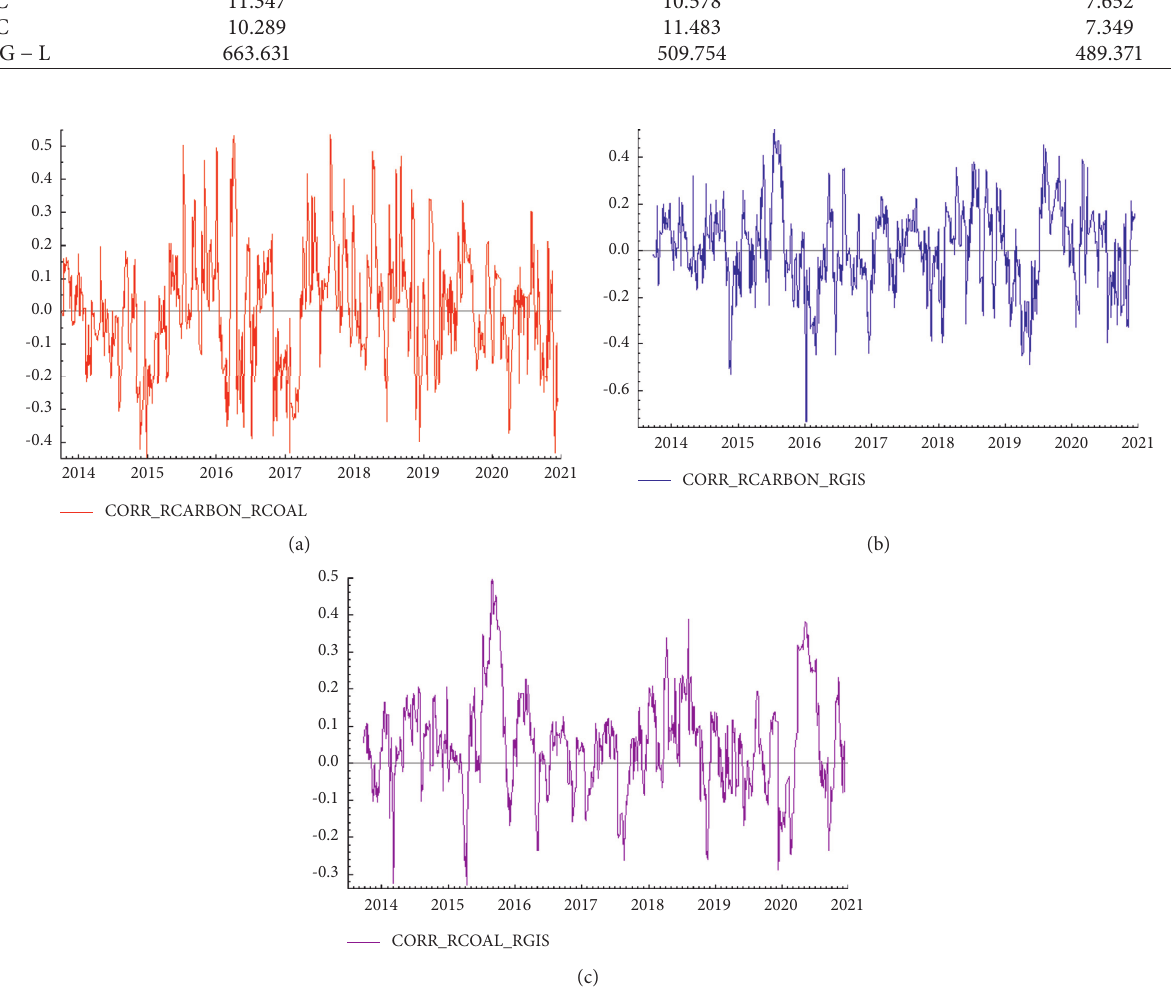
Figure 3: The trend of dynamic conditional correlation. (a) The dynamic conditional correlation between carbon and coal market returns. (b) The dynamic conditional correlation between carbon market returns and green investing market. (c) The dynamic conditional correlation between coal and green investing